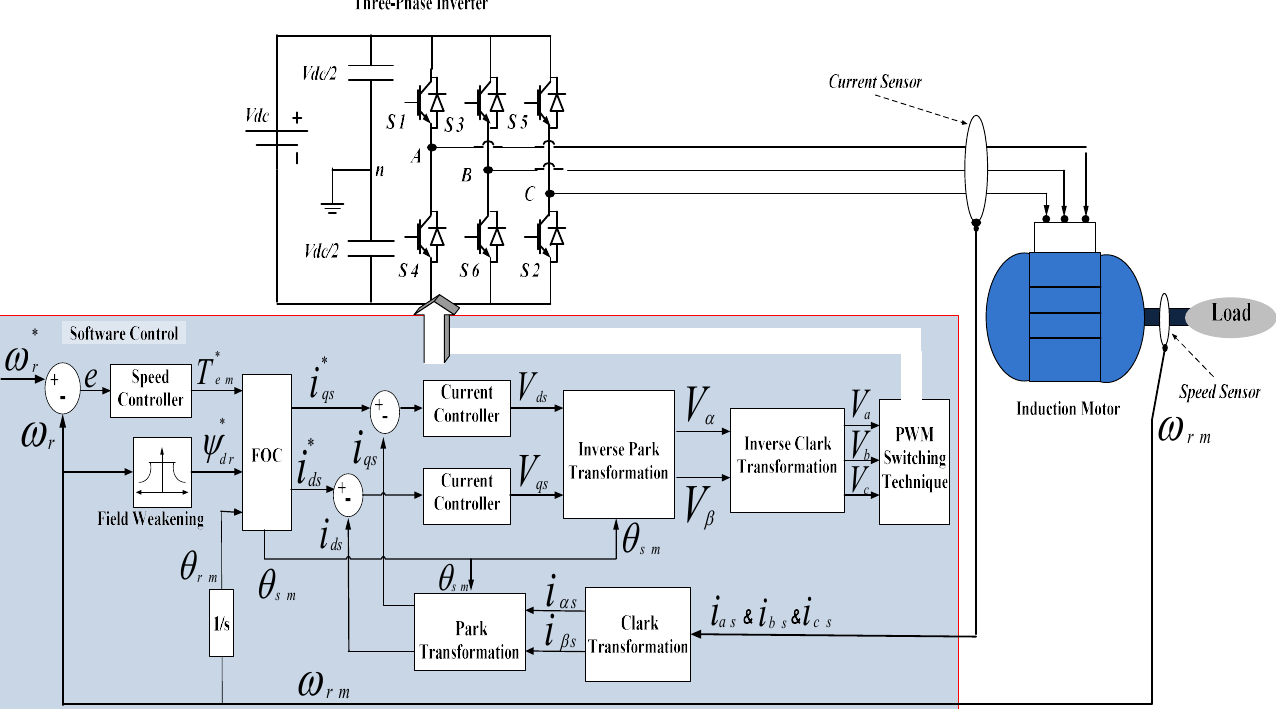
Figure 8. Block diagram of IFOC for IM drive.